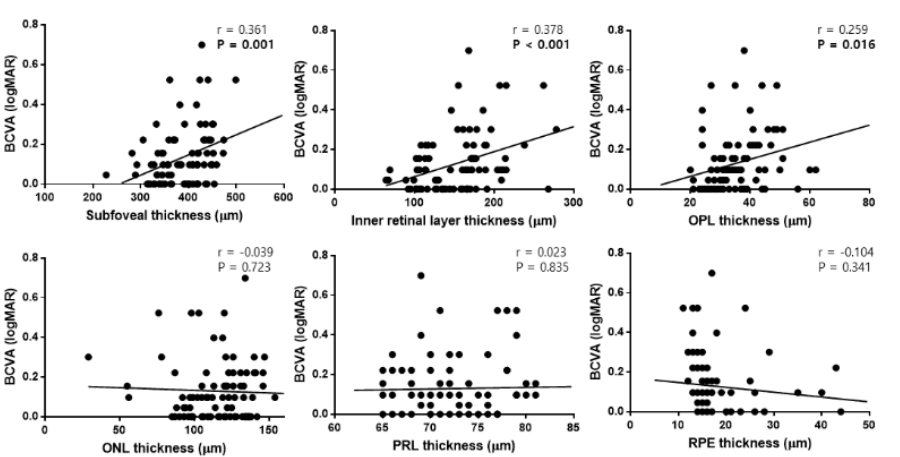
Figure 5. Scatter plots showing the associations between retinal layer thicknesses at 12 months postoperatively and the final best-corrected visual acuity (BCVA) in patients with epiretinal membrane. Subfoveal thickness, inner retinal layer thickness, and outer plexiform layer (OPL) thickness were significantly correlated with the final BCVA. ONL, outer nuclear layer; PRL, photoreceptor layer; RPE, retinal pigment epithelium.